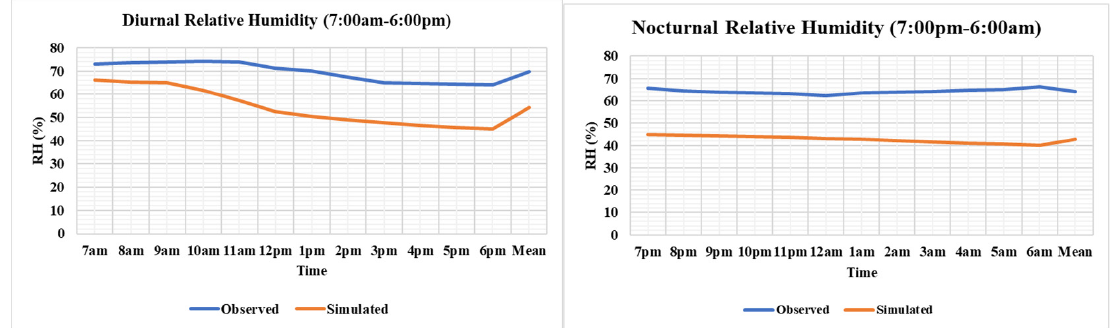
Figure 3. Measured and simulated results of diurnal and nocturnal relative humidity at FBTS.